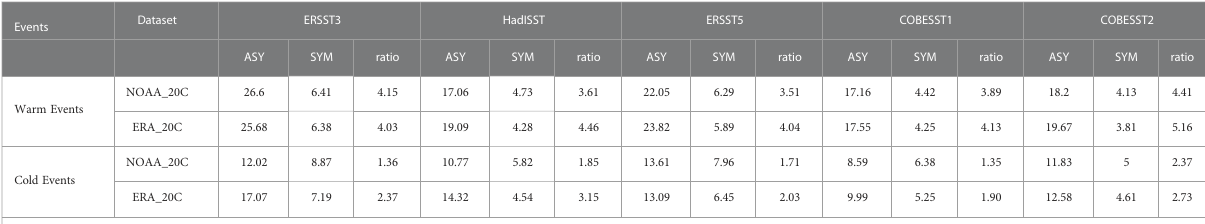
TABLE 1 Coef fi cients of regression between the PC1 values of HES (HEA) and that of the SES (SEA), and their response contrast obtained from multiple reanalysis fi elds. Events Dataset